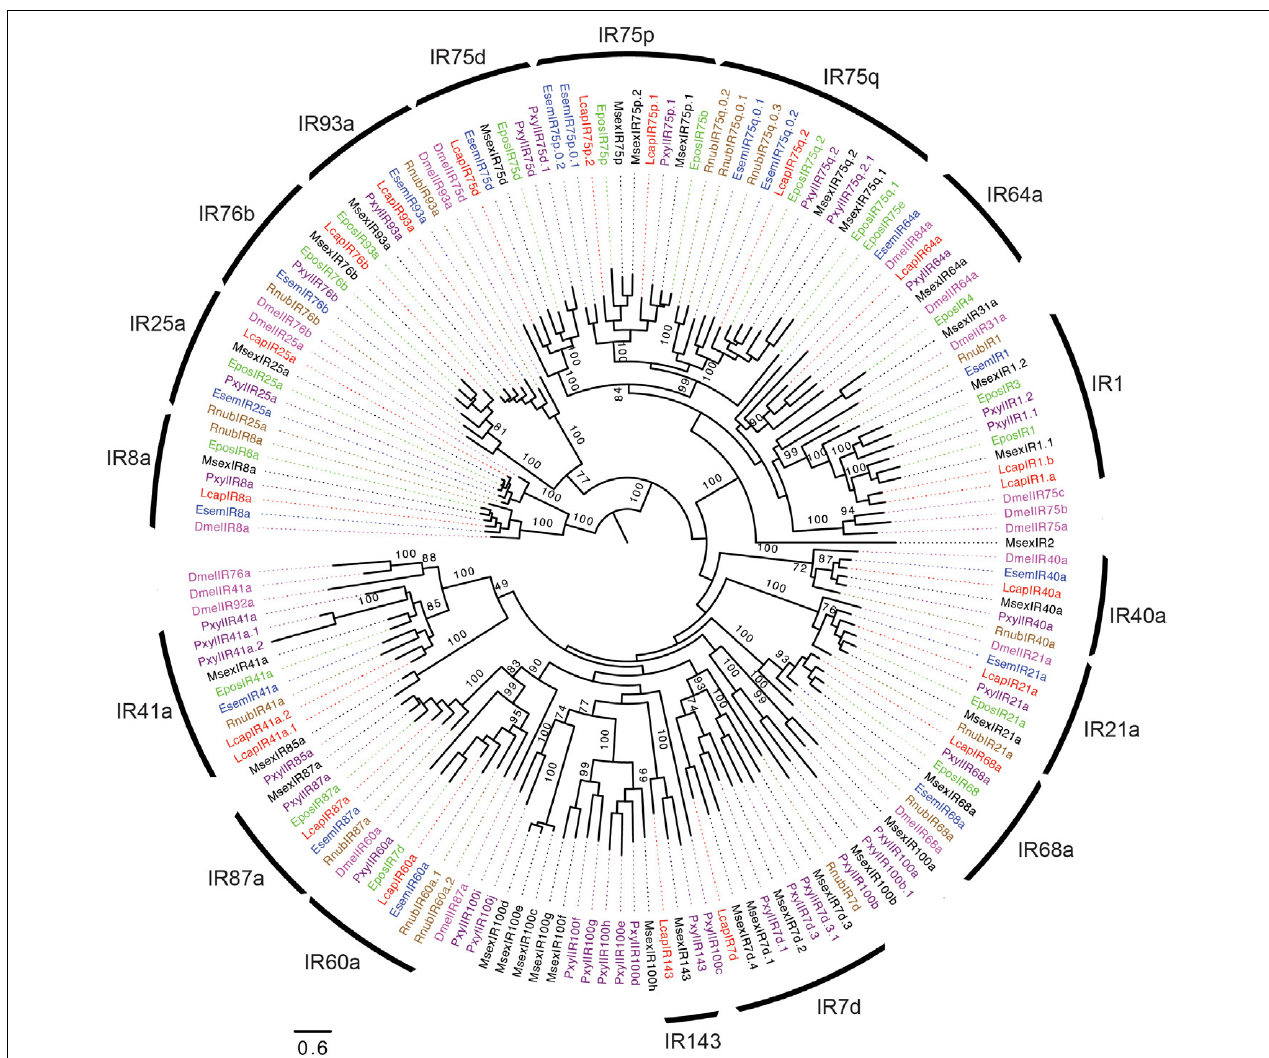
FIGURE 3 | Maximum-likelihood phylogram of ionotropic receptors (IRs), rooted with the IR8a and IR25a subfamilies. Included are IRs from R. nubila (brown), L. capitella (red), E. semipurpurella (blue), E. postvittana (green), M. sexta (black), P. xylostella (purple), and conserved IRs from Drosophila melanogaster (Magenta). Bootstrap support values (500 replicates) are indicated when > 70%. Sources of included IR sequences, along with their accession numbers (when applicable), are reported in Supplementary Data Sheet S4 .